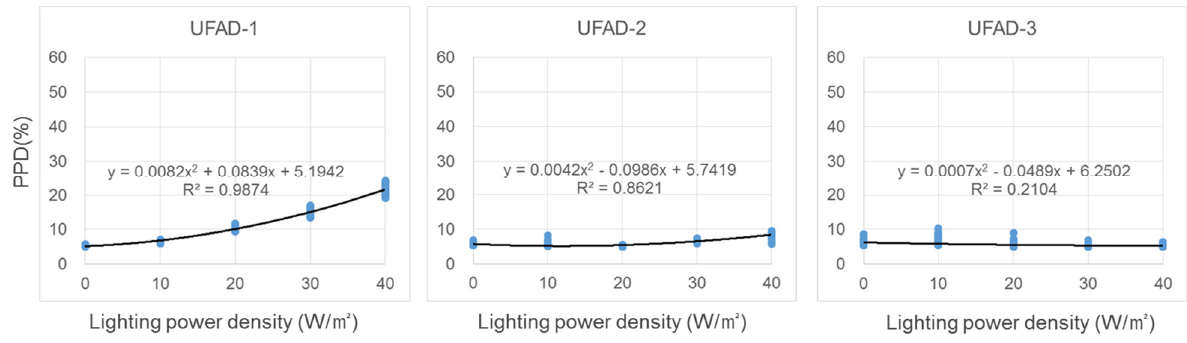
Figure 28. Correlation between lighting power density and PPD for CBAD.